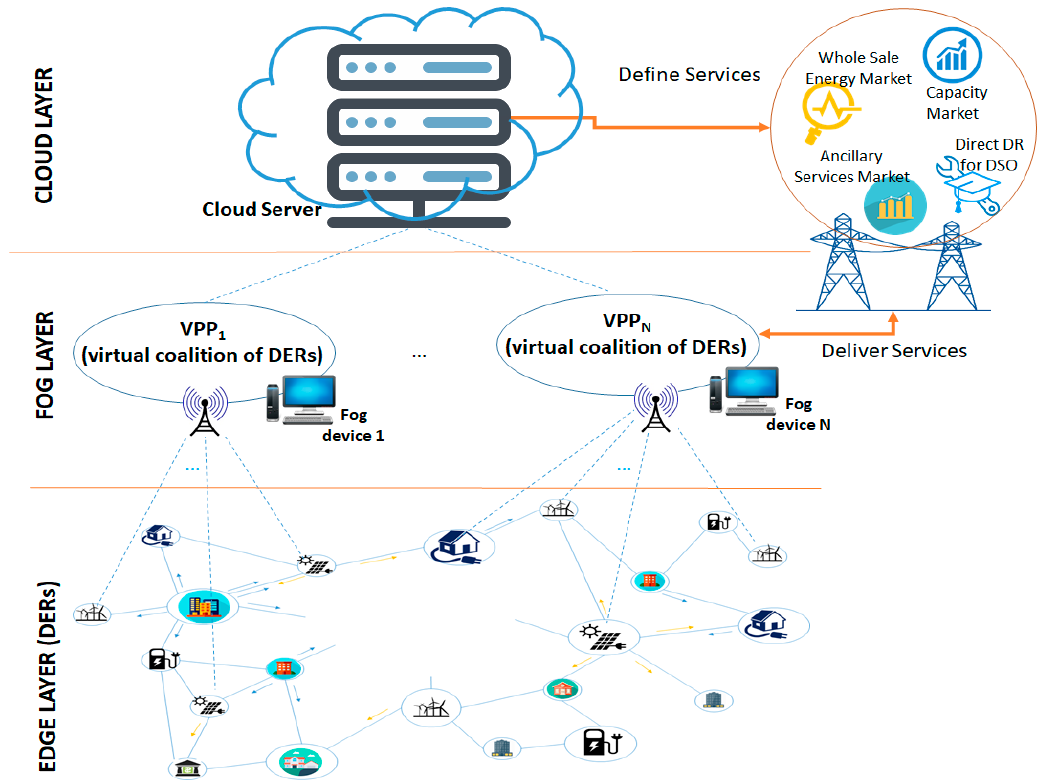
Figure 1. Fog computing and Virtual Power Plant (VPP) model in smart grids.